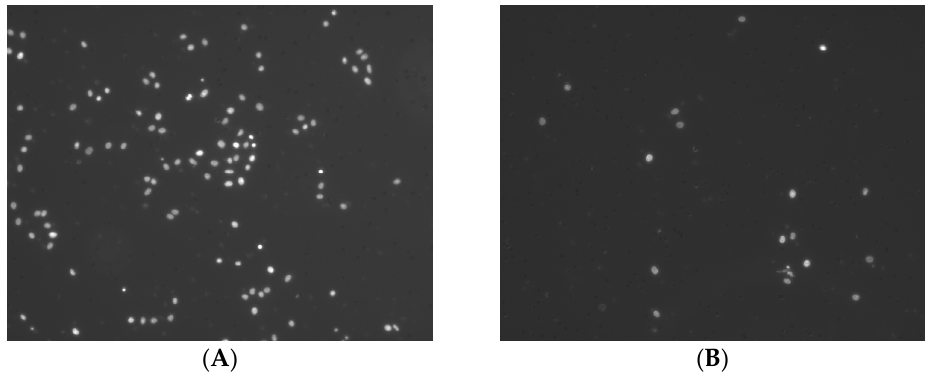
Figure 3. Tumor cell invasion: ( A ) Invasive PCI-13 cells without indirect MC stimulation and ( B ) Invasive PCI-13 cells after indirect MC stimulation (MCM).